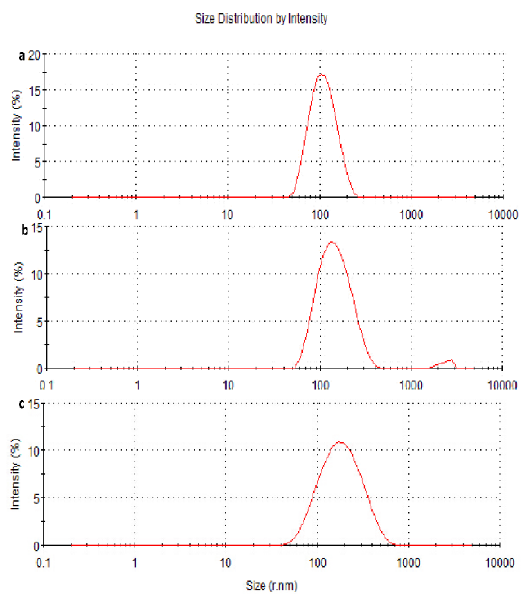
Figure 2. Single-factor investigation: influence of rotational speed on particle size. The size distribu- tions of nanoparticles ( a – c ) were assessed at stir rates of 800, 1000, and 1200 r·min −1 , respectively.